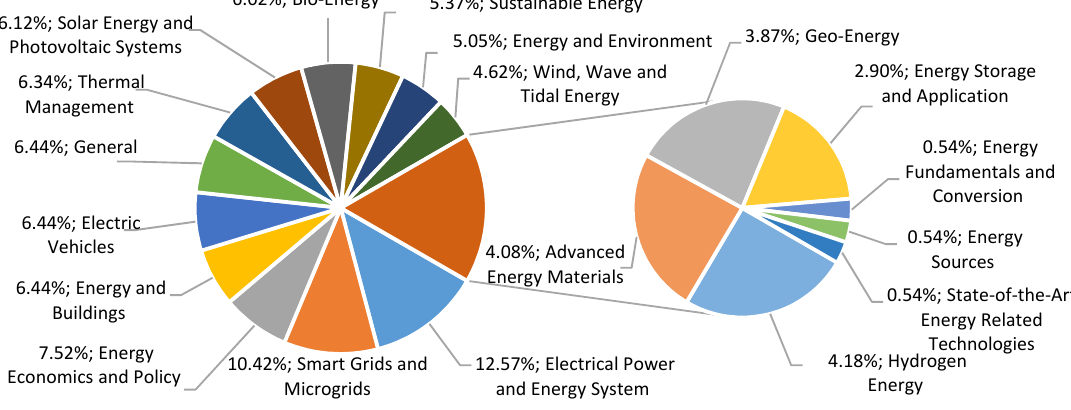
Figure 5. Distribution of Special Issues by section.